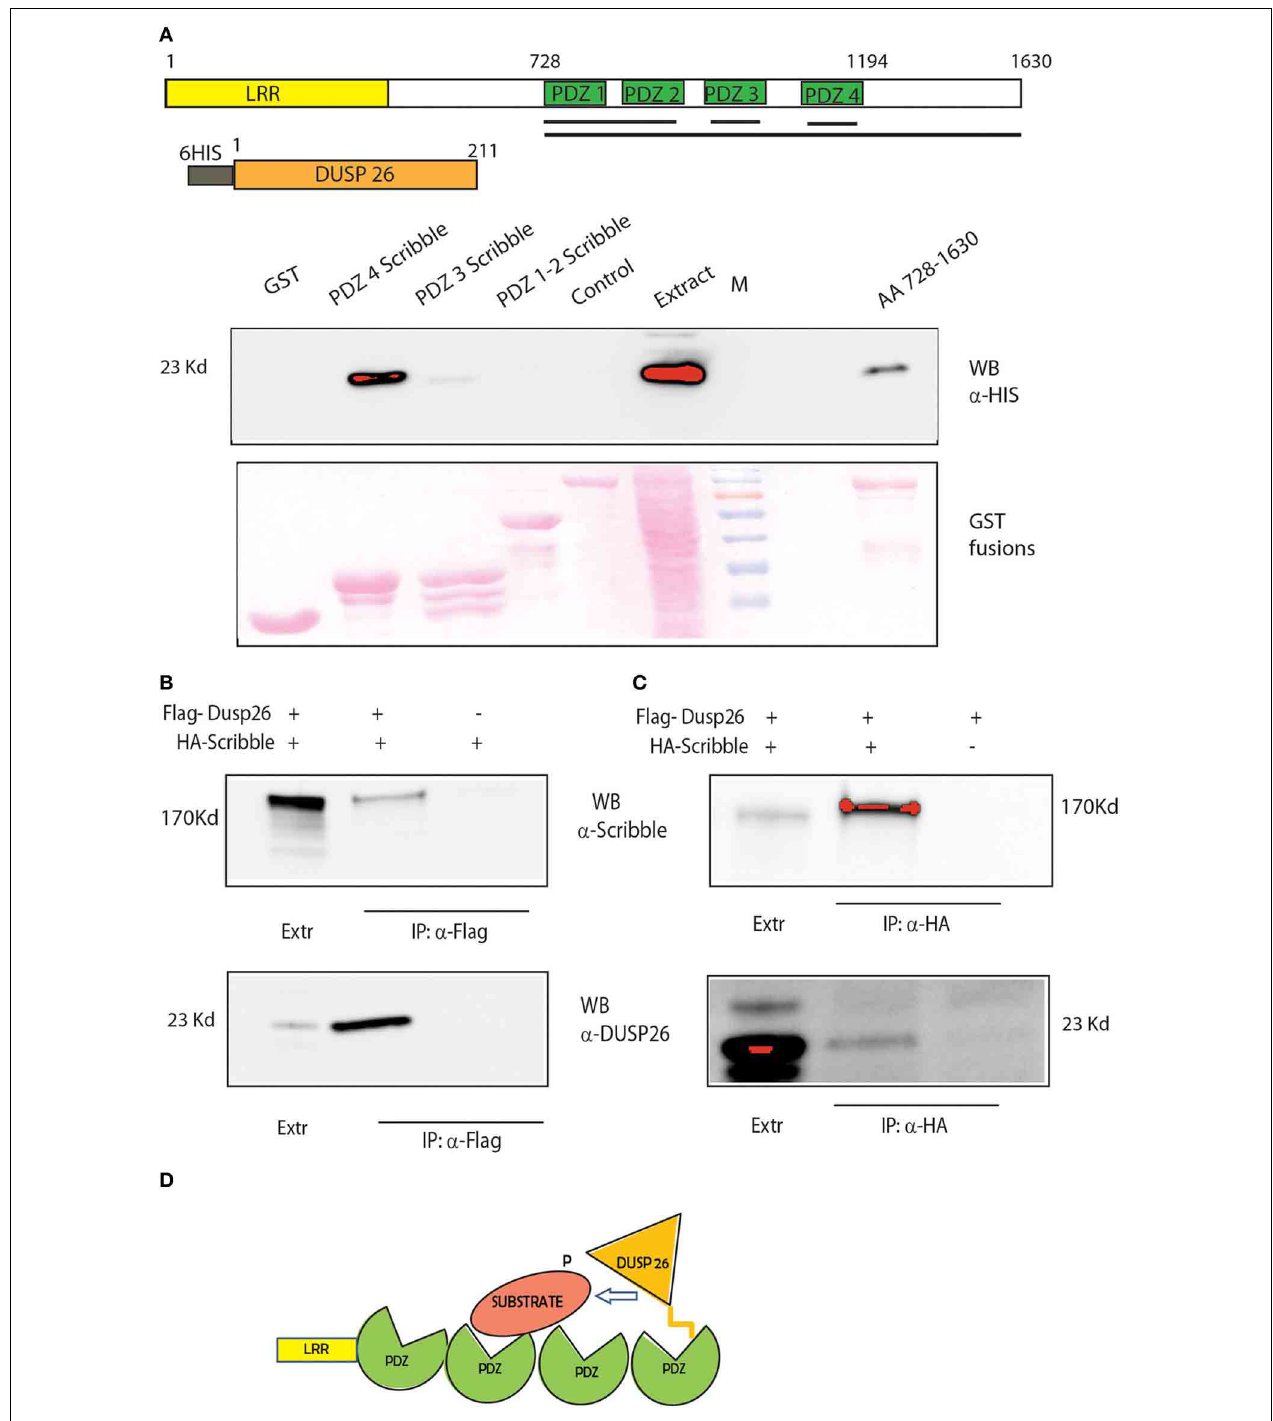
FIGURE 7 | DUSP 26 interacts with the adapter protein SCRIB. (A) GST Pull Down of full-length DUSP26 by GST constructs fused to PDZ 1-2, PDZ3, PDZ4, or all the four PDZ domains (aa 728-1630) of SCRIB fused to GST. Black Lines under the schematic representation of the domain structure of SCRIB indicate the protein regions that were fused to GST. Two controls were added: GST alone and a PDZ containing protein of similar length